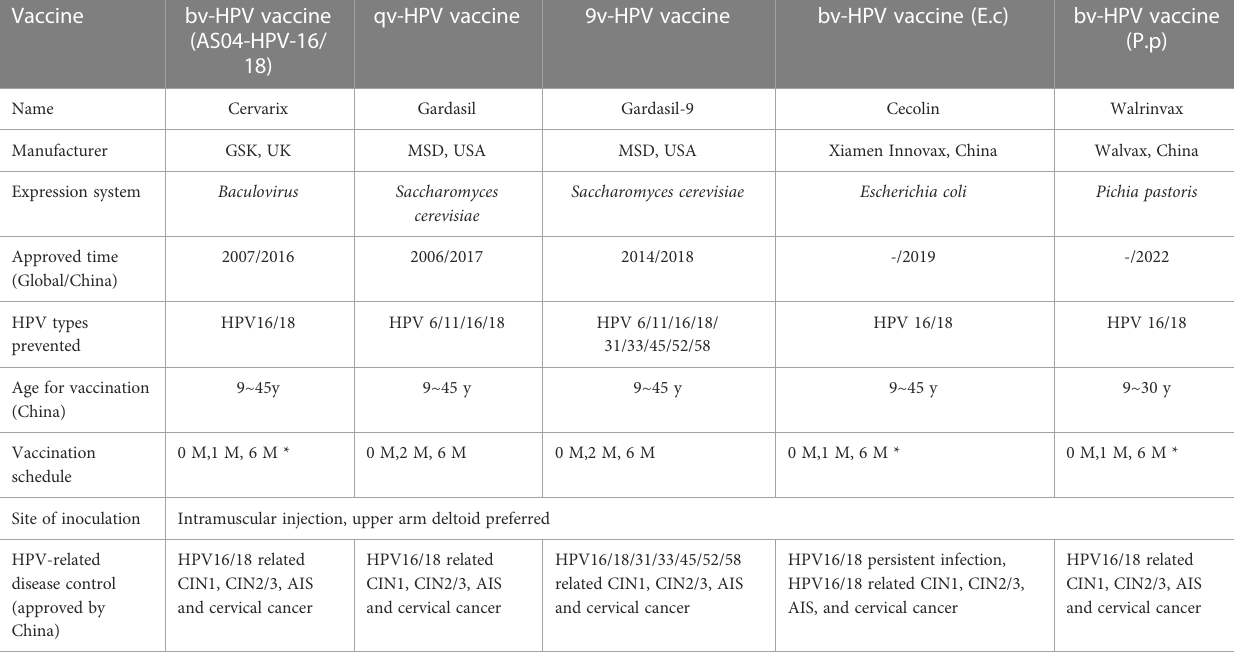
TABLE 1 Prophylactic HPV vaccine approved for use in